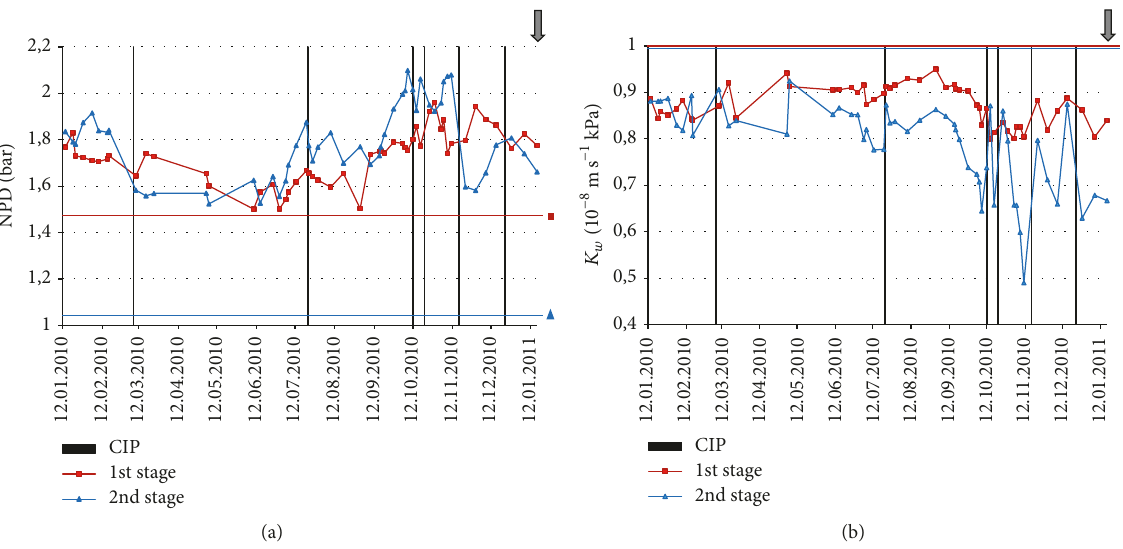
Figure 3: Key performance parameters NPD (a) and 𝐾 𝑤 (b) of plant location III. Vertical lines indicate CIP. Horizontal lines indicate performance with new membranes [day zero]. From this installation, a lead element from the first stage was taken (12.01.2011). Time point of membrane autopsy is indicated with dark grey